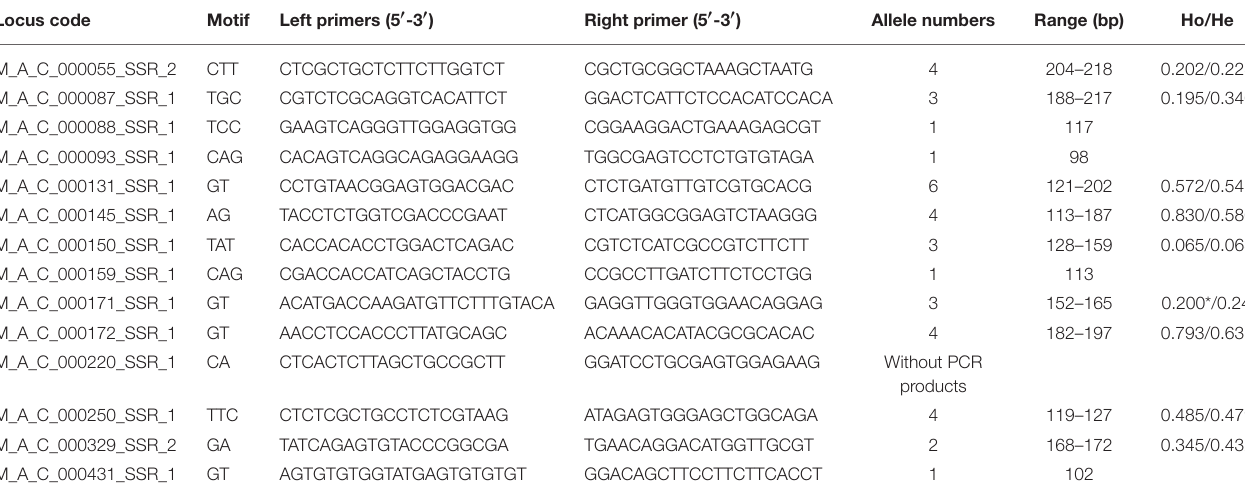
TABLE 5 | Summary of the subgroup of SSRs (14) evaluated. Locus